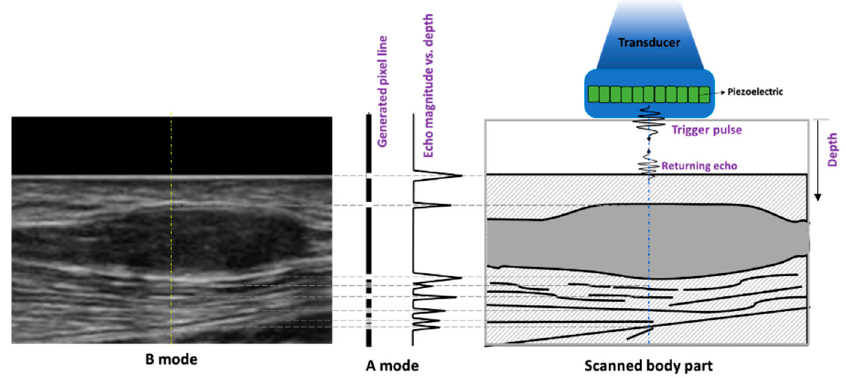
Figure 1. Schematic description of echo-ultrasonography technique as well as A- and B-mode data generation concepts. The returning pulse from the scatterers (schematically shown on the right) encountered by the trigger pulse, generated by an exemplary piezoelectric transducer within the US probe, is used to generate A-mode data as well as a pixel line (shown in the middle) of the final B-mode image (shown on the left).